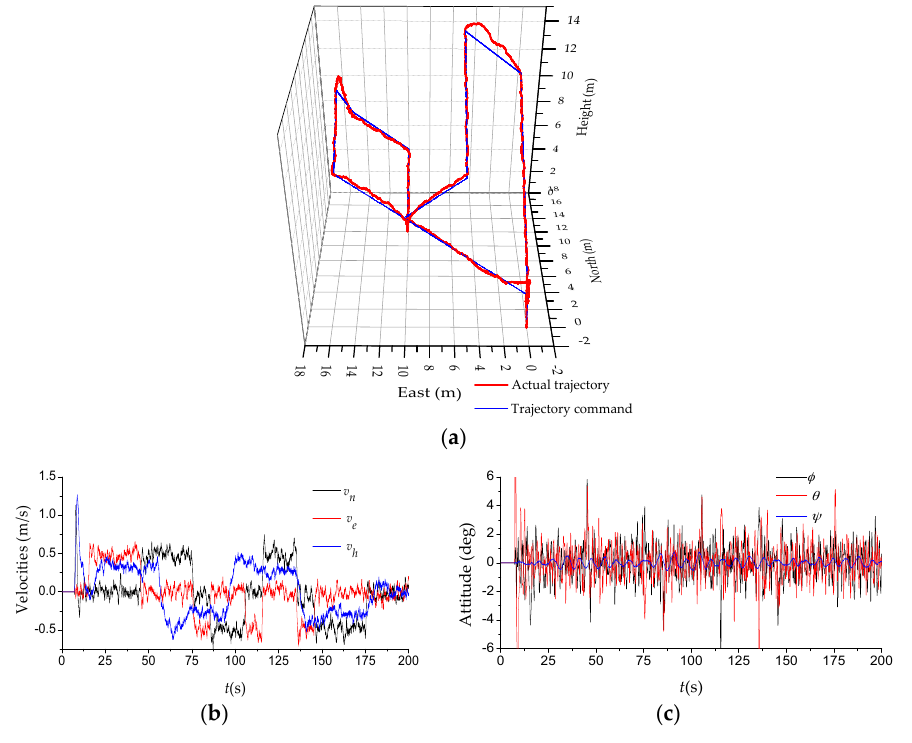
Figure 12. The experimental results of the conventional method during near-hover operations: ( a ) 3D flight trajectory tracking; ( b ) flight velocities; and ( c ) attitude.